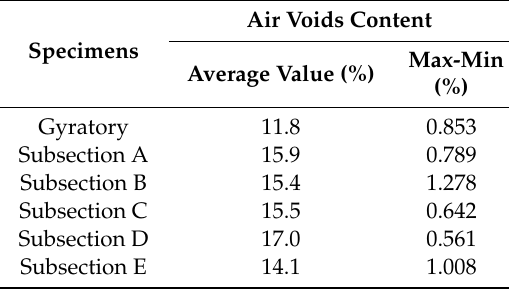
Table 9. Air voids content of CRAM binder specimens of Group 0 and Group 2.